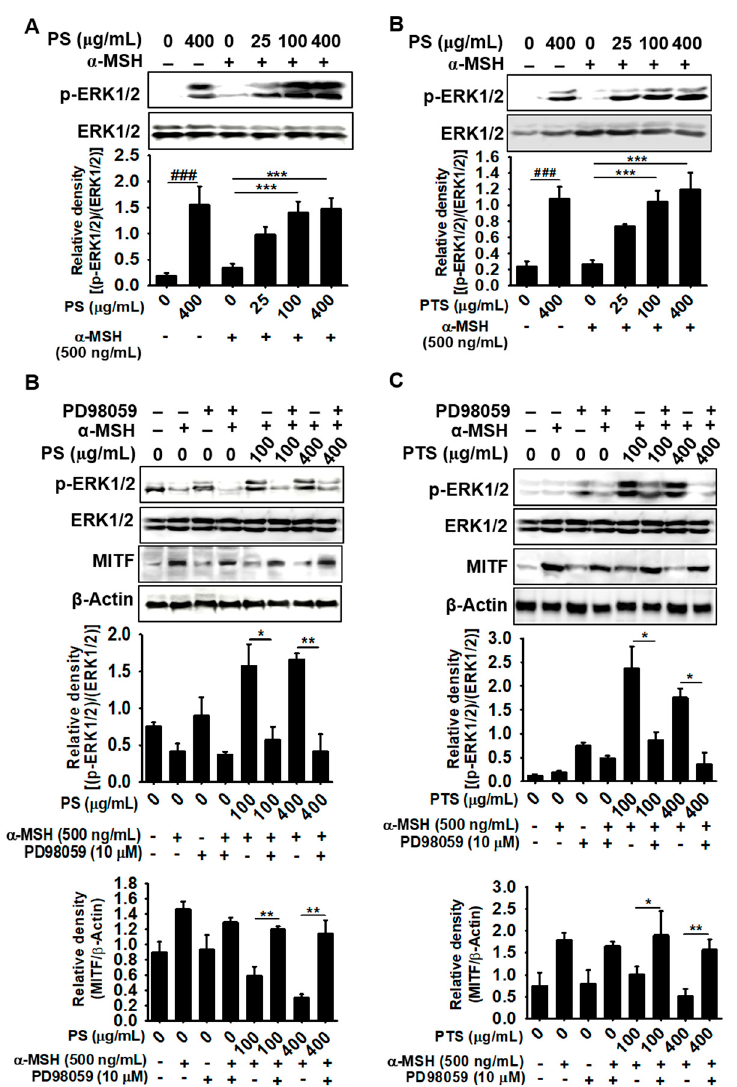
Figure 6. PS- and PTS-induced ERK phosphorylation downregulates MITF expression. ( A , B ) B16F10 Figure 6. PS ‐ and PTS ‐ induced ERK phosphorylation downregulates MITF expression. ( A and B ) cells were pretreated with 500 ng / mL of α -MSH and then treated with PS or PTS (each 0–400 µ g / mL) for B16F10 cells were pretreated with 500 ng/mL of α‐ MSH and then treated with PS or PTS (each 0–400 72 h, and ERK phosphorylation was analyzed by western blotting analysis (A, PS-treated; B, PTS-treated). μ g/mL) for 72 h, and ERK phosphorylation was analyzed by western blotting analysis (A, PS ‐ treated; ( C , D ) The cells were pretreated with PD98059 (10 µ M) for 1 h, and then treated with 500 ng / mL of B, PTS ‐ treated). ( C and D ) The cells were pretreated with PD98059 (10 μ M) for 1 h, and then treated α -MSH in the absence or presence of PS or PTS (each 100 µ g / mL and 400 µ g / mL) for 72 h. Next, the with 500 ng/mL of α‐ MSH in the absence or presence of PS or PTS (each 100 μ g/mL and 400 μ g/mL) levels of p-ERK1 / 2 and MITF in cell lysate were analyzed by western blotting analysis (C, PS-treated; for 72 h. Next, the levels of p ‐ ERK1/2 and MITF in cell lysate were analyzed by western blotting D, PTS-treated). The percentage values are relative to those in the untreated group. The data are analysis (C, PS ‐ treated; D, PTS ‐ treated). The percentage values are relative to those in the untreated represented as the means ± SEM of three separate experiments ( n = 3). ### p < 0.001 vs. untreated group; group. The data are represented as the means ± SEM of three separate experiments ( n = 3). ### p <0.001 * p < 0.05, ** p < 0.01 and ** p < 0.001 vs. α -MSH-stimulated vs. untreated group; * p < 0.05, ** p < 0.01 and ** p < 0.001 vs. α‐ MSH ‐ stimulated group.